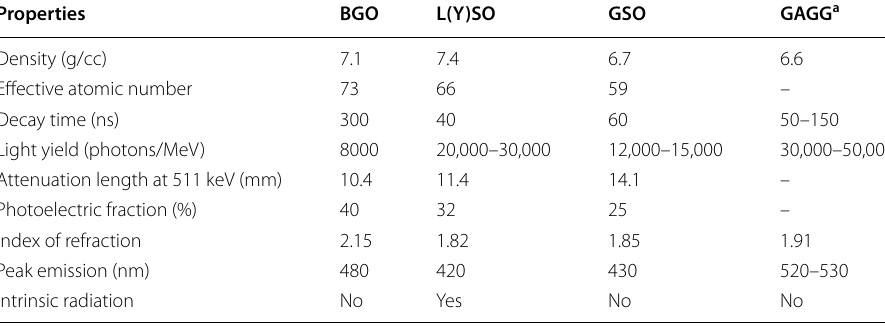
a Date from https:// www. epic- cryst al. com/ oxide- scint illat ors/ gagg- ce- scint illat or. html. GAGG with different components shows different performances